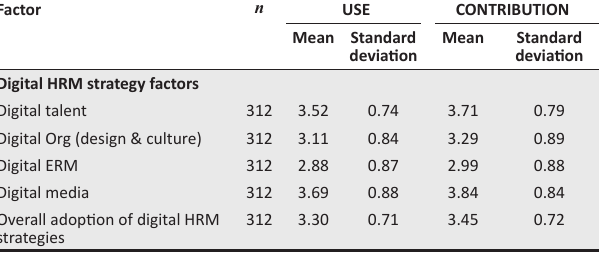
TABLE 2: Descriptive statistics for the